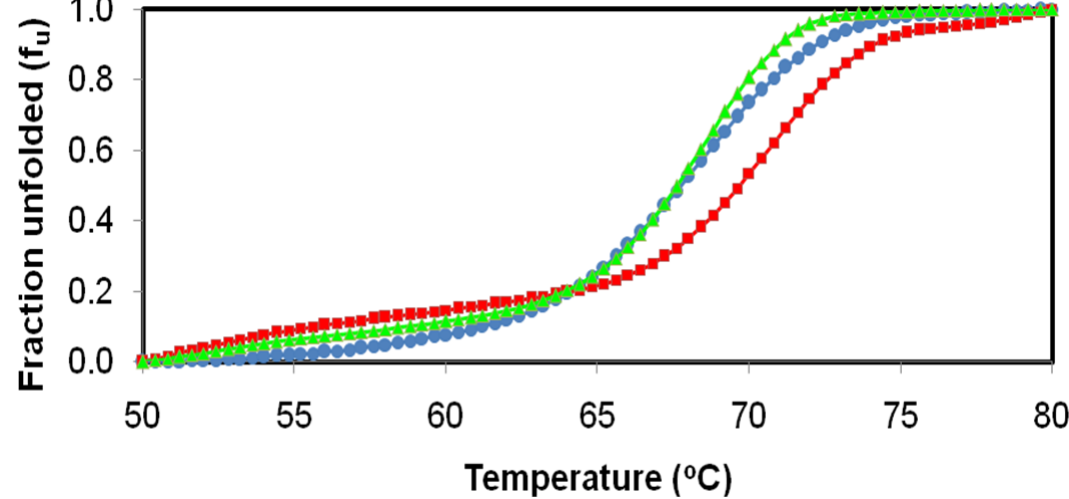
Figure 2. Denatured protein analysis by circular dichroism. T ~68.52 °C, K344R lipase (green) at ~68.54 °C and D311E lipase (red) at ~70.59